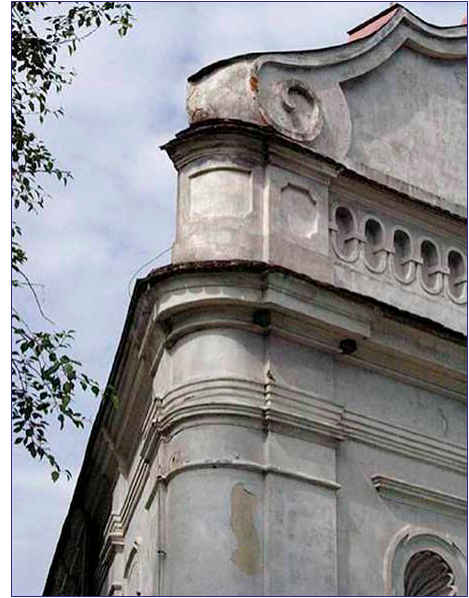
fig. 4. Stróża k. Kraśnika. Holy Trinity church, j. Horsz, 1766 – 1767. Detail of the corner. Photo: j.- K. lenartowicz